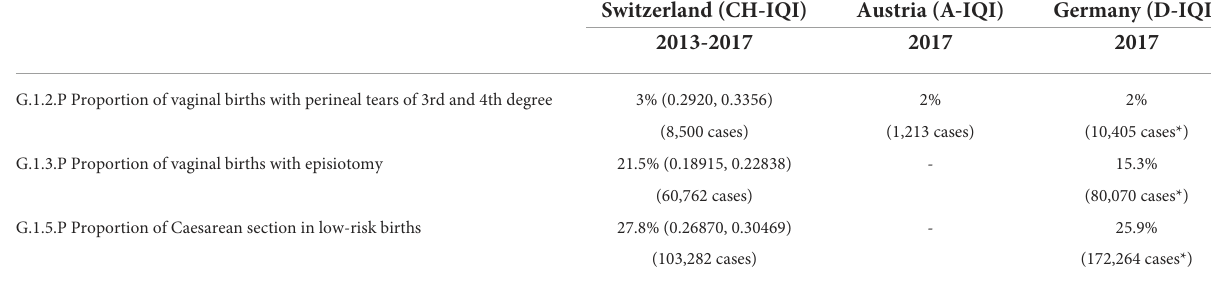
TABLE 1 Quality indicators of obstetrics in comparison between Switzerland, Austria and